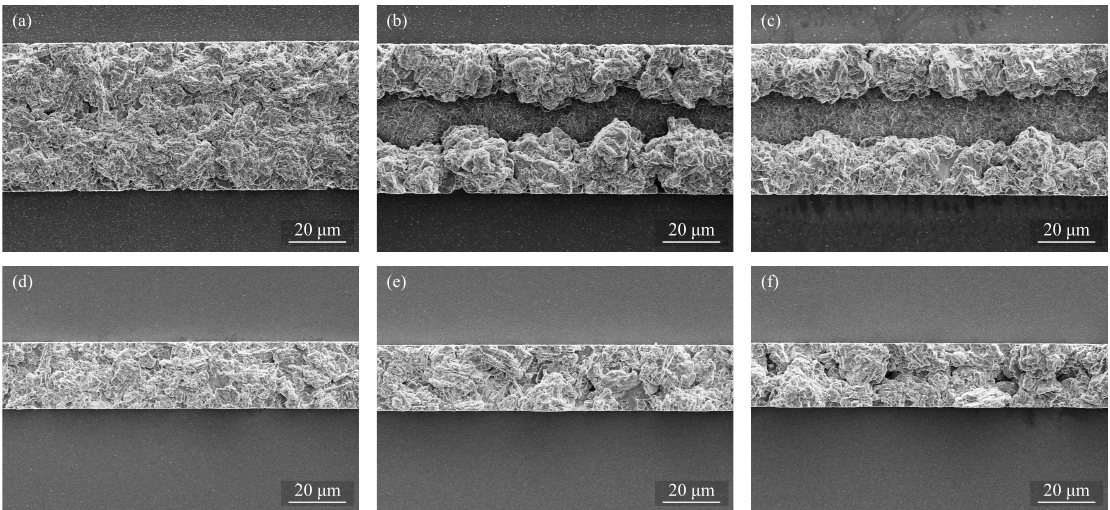
Figure 16. SEM images of the pattern-deposited films on an Al seed layer with 50 µm frame width obtained at ( a ) 10; ( b ) 15; ( c ) 20 mA/cm 2 and with 20 µm frame width obtained at ( d ) 10; ( e ) 15; and ( f ) 20 mA/cm 2